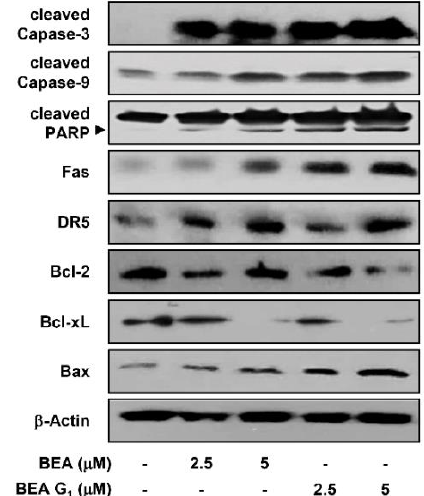
Figure 7. Effects of BEA and BEA G 1 on the expression of apoptosis regulatory proteins in A375SM melanoma cells. The cells were treated with BEA and BEA G 1 (2.5 and 5 μM) for 24 h, and protein levels were detected by Western blot analysis using specific antibodies. The levels of β -actin were used as an internal control. Arrowheads indicate cleaved forms.